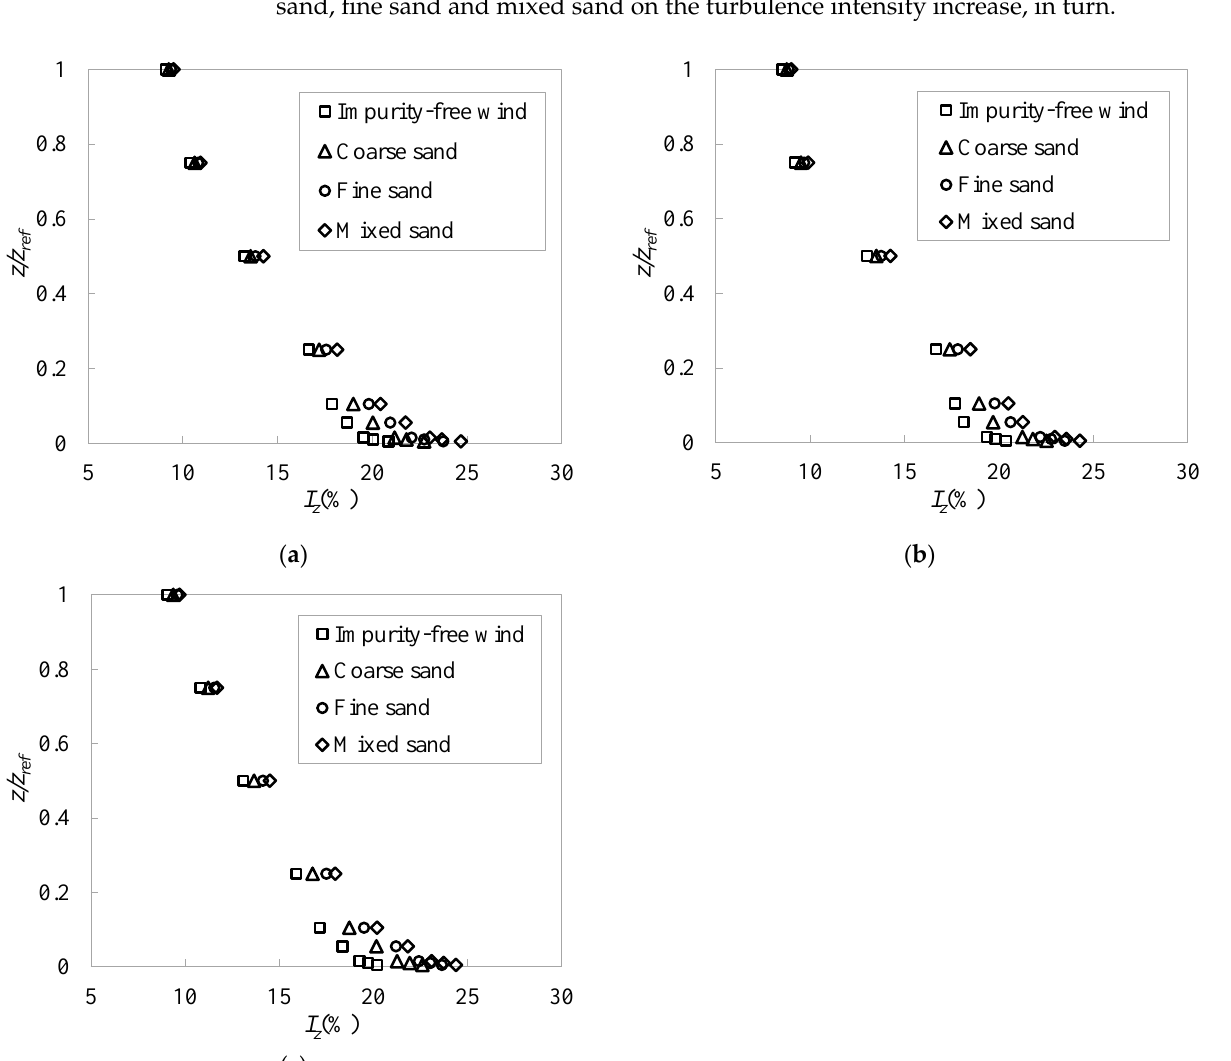
Figure 11. The influence of particle movement on the wind speed: ( a ) At the indicated wind speed of 14.74 m/s; ( b ) At the indicated wind speed of 16.68 m/s; ( c ) At the indicated wind speed of 18.61 m/s.